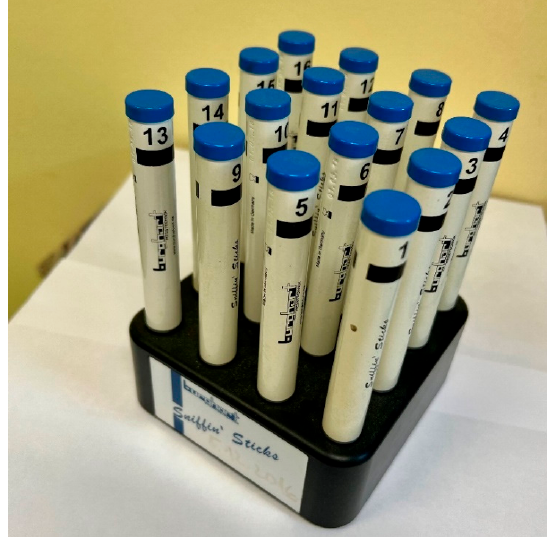
Figure 6. Sniffin ‘Sticks test from Burghart (from co-author’s archive).